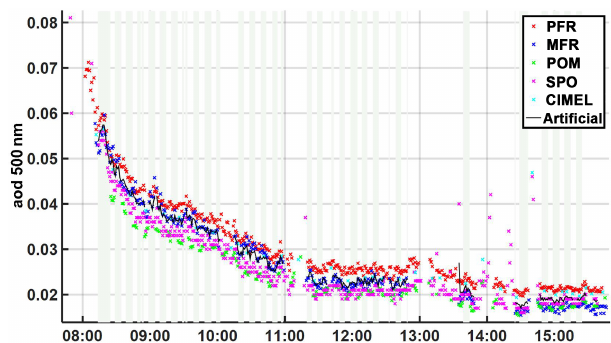
Figure 8. One-minute AOD data on 1 October 2015. Different col- ors represent the AODs, submitted as cloud-free data. The black line is the mean AOD from the PFR, MFR and SPO for data points when all three instruments provided data. The gray vertical lines represent periods where the PFR, MFR and SPO provided data but the POM characterized them as